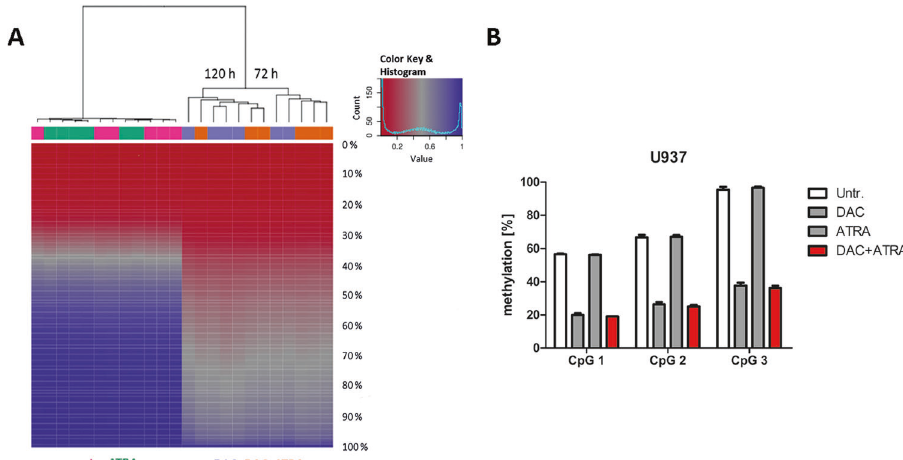
Fig. 6 Global DNA demethylation by DAC is not enhanced by ATRA. A U937 cells (technical triplicates) were treated with either DAC (lilac), ATRA (green), DAC + ATRA (orange) or left untreated (untr.; pink) and analyzed after 72 and 120 h. Global DNA methylation was acquired by In fi nium HumanMethylation450 BeadChip Assay [8]. Methylation data was analyzed with RnBeads as described in Materials and Methods and Suppl. Methods. The heatmap displays the methylation percentiles (%) for all 24 samples analyzed. Unsupervised, hierarchical clustering showed subclustering in the DAC/DAC + ATRA arm for the two time points with an outlier in the 120 h group. B LINE-1 methylation of three selected CpGs was determined by MassArray in U937 cells (technical triplicates) treated with DAC, ATRA or DAC + ATRA at 72 mean FC DAC + ATRA 1.03 vs. mean FC DAC 0.97). On the other